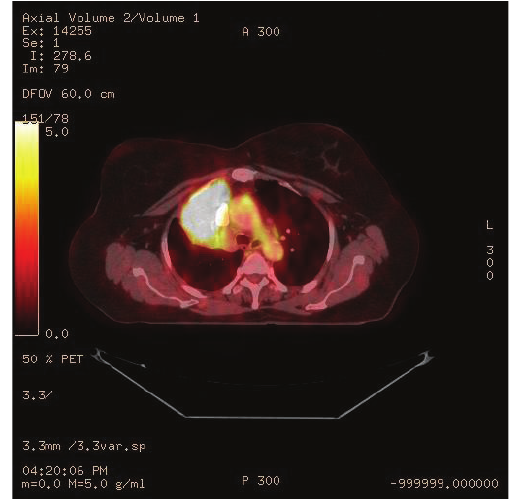
Figure 2: PET SCAN image showing FDG avid large right upper lobe heterogeneous low-density mass causing mass e ff ect upon the main stem bronchus.